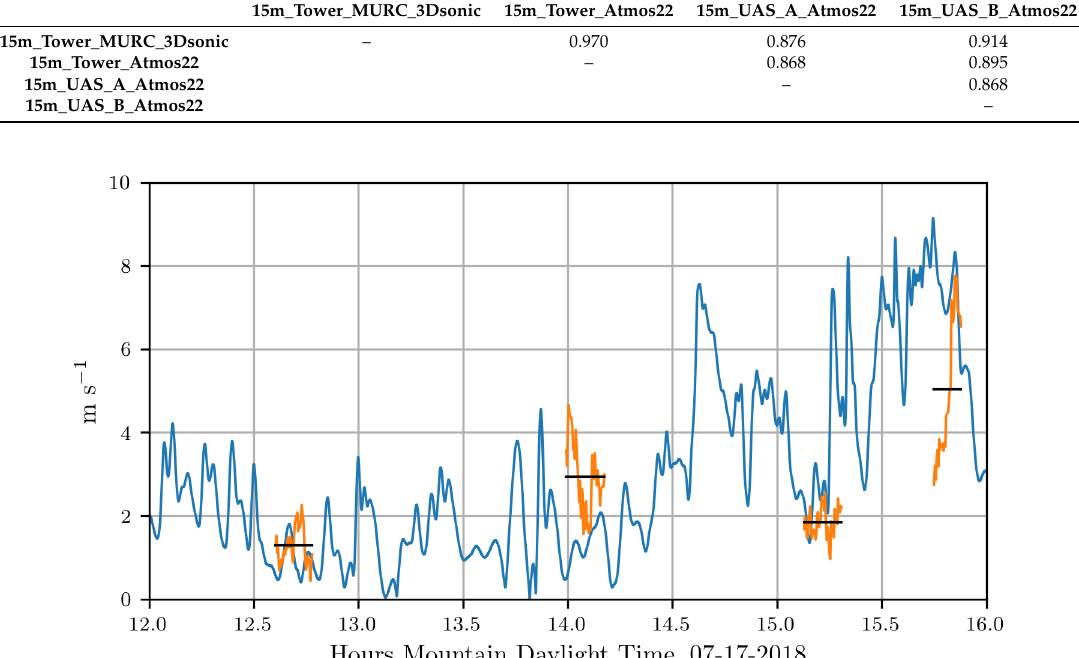
Figure 11. Wind speed from WRF-LES grid point nearest to where the attraction rate was calculated (blue) and wind speed as measured by sensors, interpolated to the attraction rate position (orange) overlaid with flight average of the wind speed (black). Wind speed from the WRF-LES comes from the 10 m height level, while wind speed measurements were performed by sensors at 15